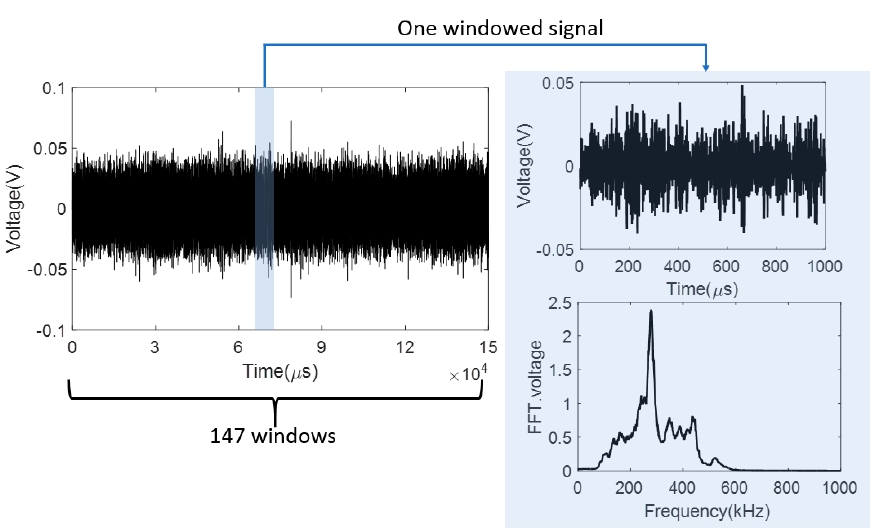
Figure 5. The window of 1 ms duration from the streamed acoustic emission (AE) signal of the NAVAIR gearbox test.